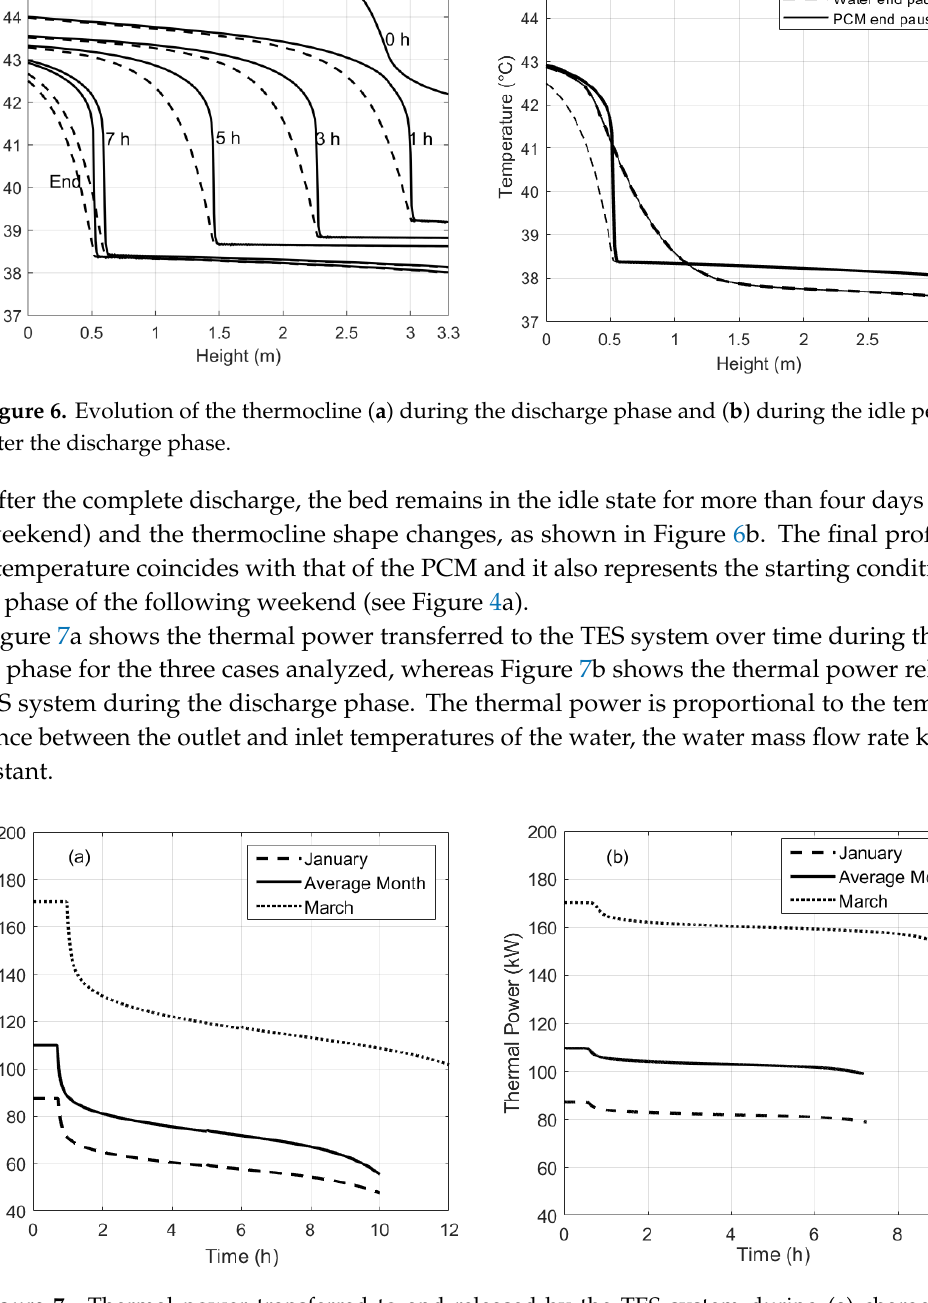
Figure 6. Evolution of the thermocline ( a ) during the discharge phase and ( b ) during the idle period after the discharge phase.